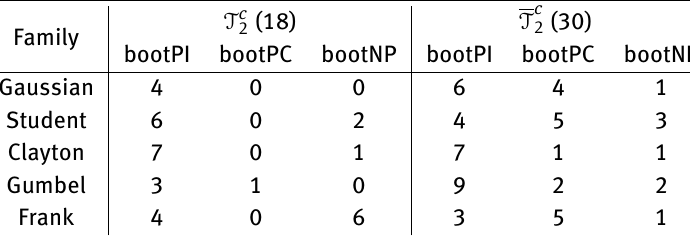
Table 3: Rejection percentages under the null (parametric tests).